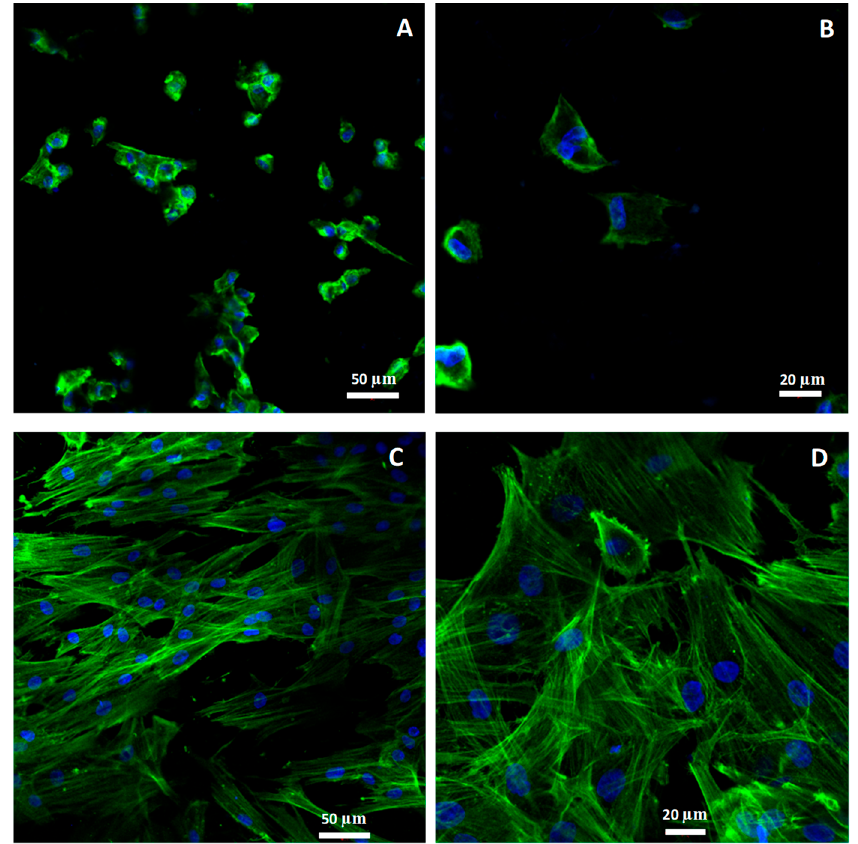
Figure 6. Confocal microscope images of fibroblasts on ZLS at magnification 20× ( A ) and 40× ( B ), and Y-TZP 20× ( C ) and 40× ( D ).